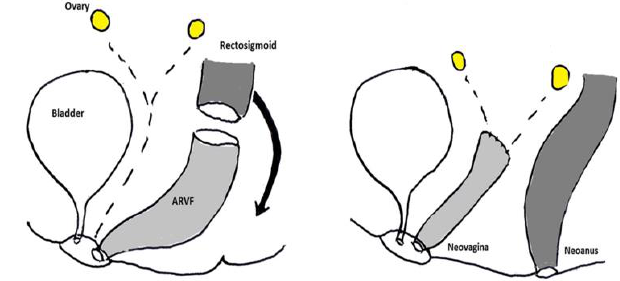
Figure 3: Using the rectovestibular fistula as the neovagina (Reproduced with permission from Kisku et al. Int Uro- gynecol J. 2015;26(10):1441-8.) [61]